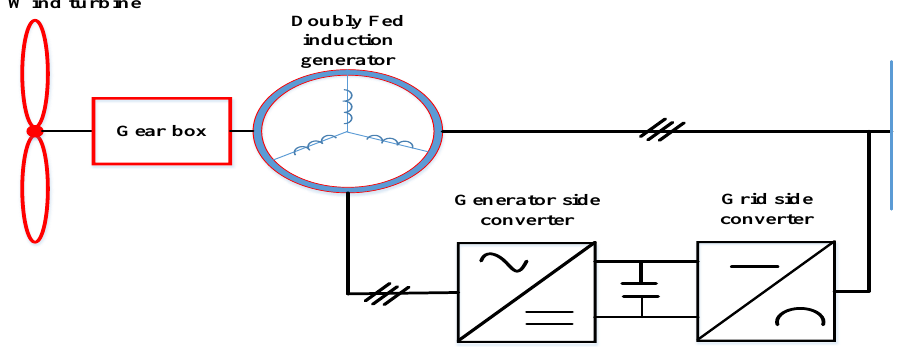
Figure 6. A doubly fed induction generator (DFIG) wind energy conversion system [63].